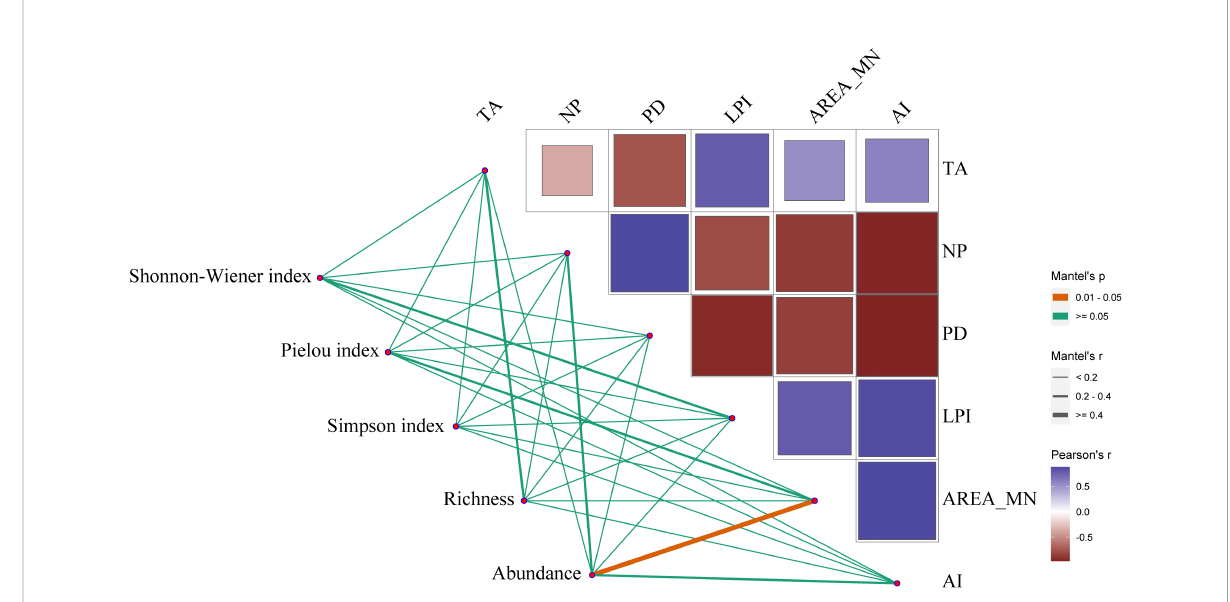
FIGURE 4 Relationships between the landscape metrics of shorebird habitat and shorebird diversity indices in the Yellow River Delta. Pairwise comparisons between shorebird diversity indices and landscape metrics of habitat are indicated by a color gradient denoting Pearson ’ s correlation coef fi cients. The non-orange lines indicate non-signi fi cant relationships, and the orange line indicates a signi fi cant relationship ( p< 0.05). The thickness of the line is positively correlated with the strength of the relationship. TA, total area; LPI, largest patch index; AREA_MN, mean patch area; NP, number of patches; PD, patch density; AI, aggregation